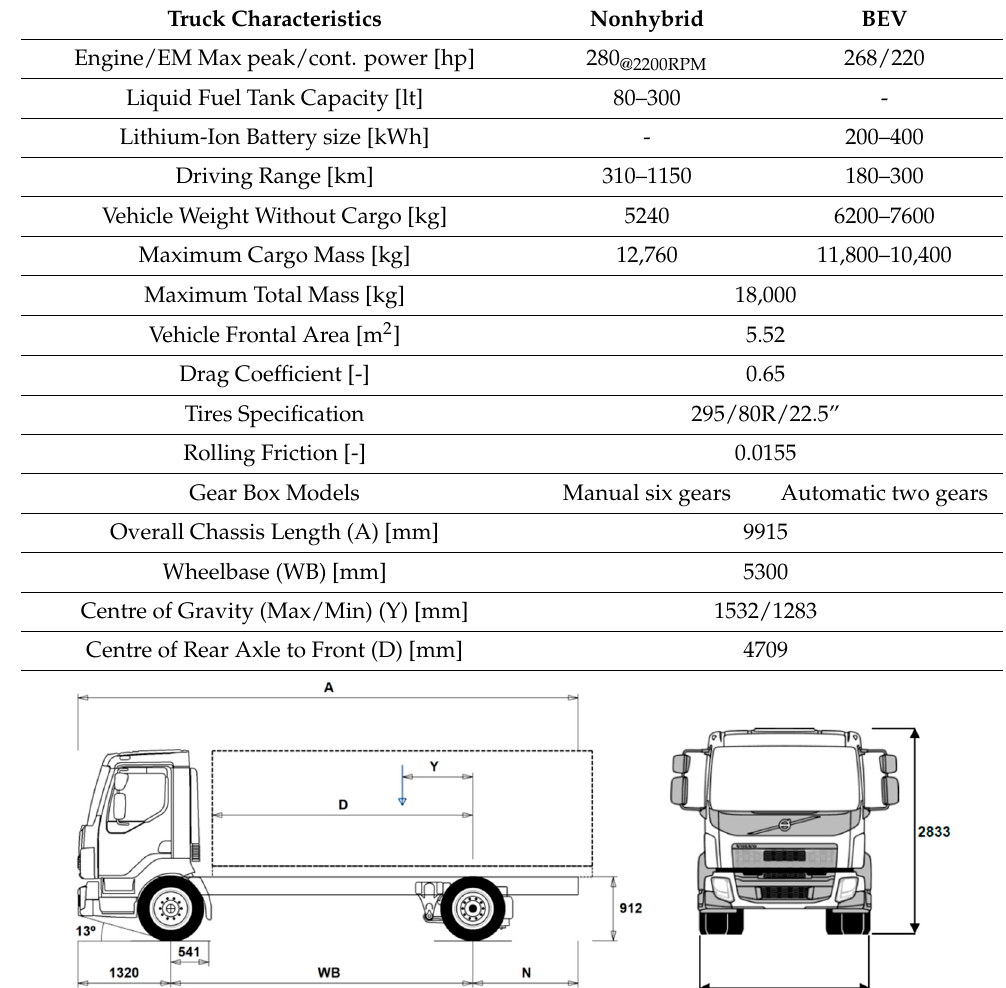
Table 1. Main vehicle characteristics of the baseline case: nonhybrid and battery electric vehicle Volvo FL 18-tons truck.